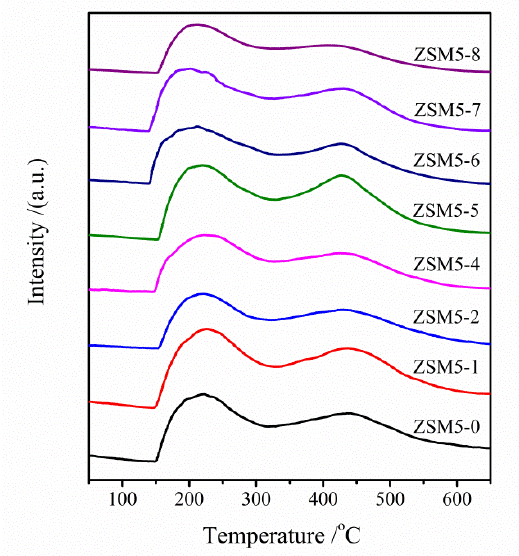
Figure 7. NH 3 -TPD patterns of ZSM-5 zeolites synthesized with different ethanol concentrations.